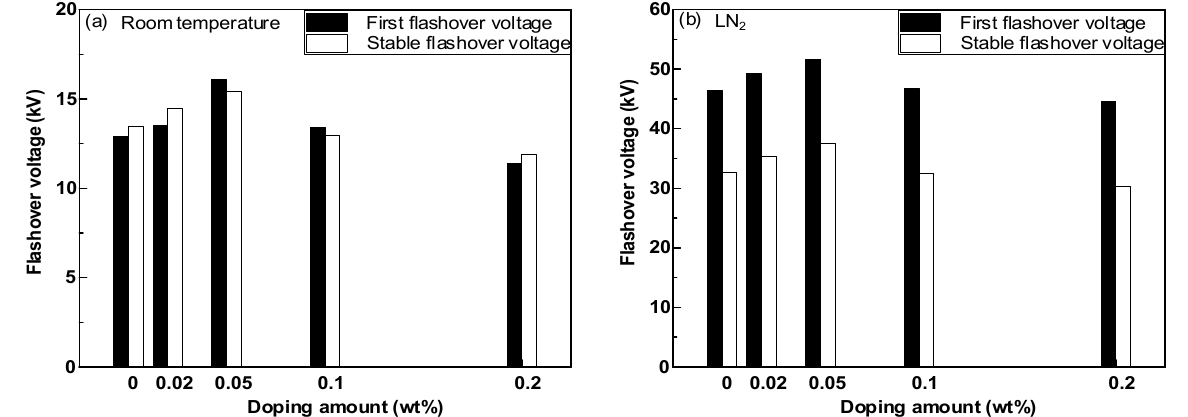
Figure 8. DC surface flashover voltage of epoxy resin–GO composites. ( a ) DC surface flashover voltage of epoxy resin–GO composites at room temperature; ( b ) DC surface flashover voltage of epoxy resin–GO composites at LN 2 .